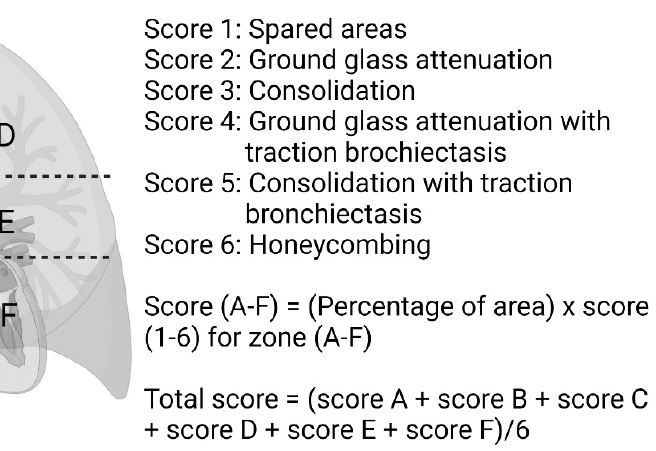
Figure 1. CT Scoring method